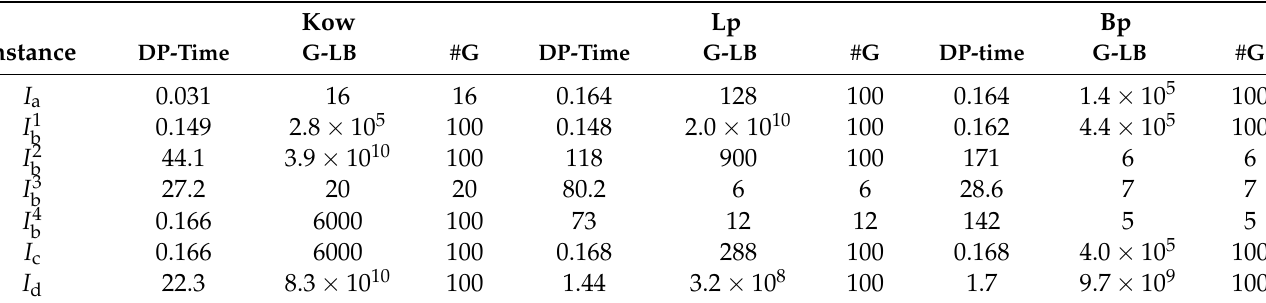
Table 13. Results of Stage 5 for K OW , L P , and B P .